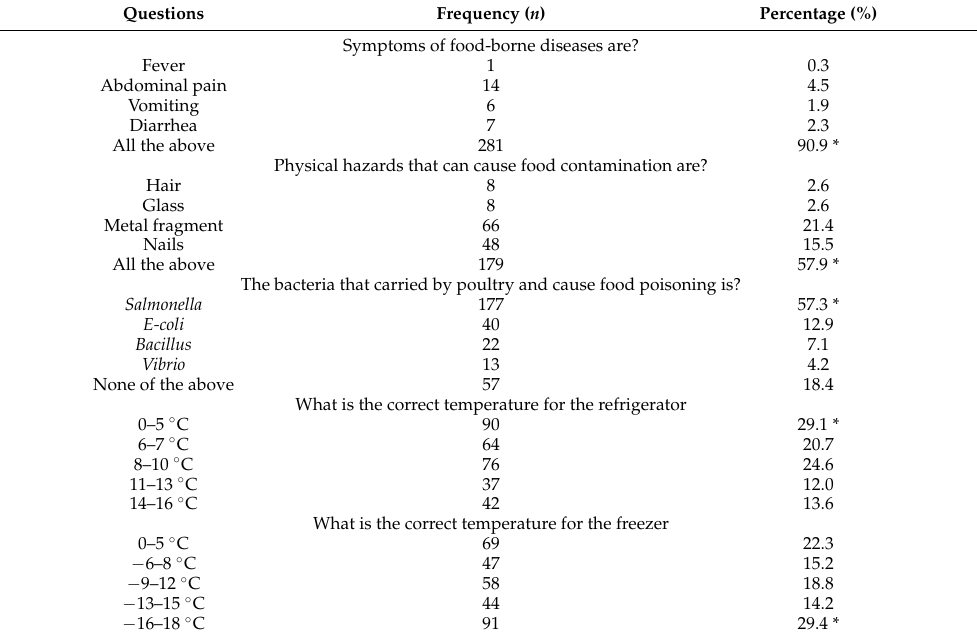
Table 2. Correct responses to common food sources of food-borne disease pathogens scale questions among Saudi